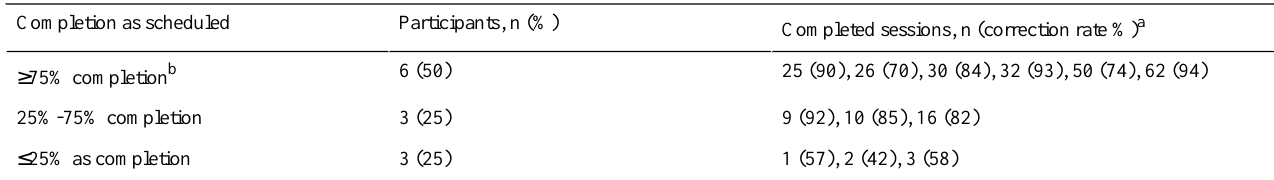
Completed sessions, n (correction rate %) a Participants, n (%)Completion as